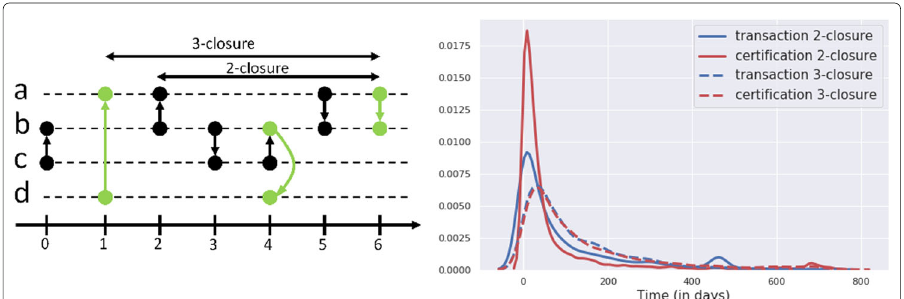
Fig. 11 Left - Illustration of the 2 and 3-closures. The 2-closure of link ( 6, a , b ) is equal to 4 since we have to go back to t = 2 to find a reversed link ( 2, b , a ) . The 3-closure of link ( 6, a , b ) is equal to 5 since we have to go back to t = 1 to close the triangle composed of ( 6, a , b ) , ( 4, b , d ) , ( 1, d , a ) . Right - The distribution of 2- and 3-closures for all links in C and T MM . Note that we only consider links with finite k-closures, links with infinite values being ignored